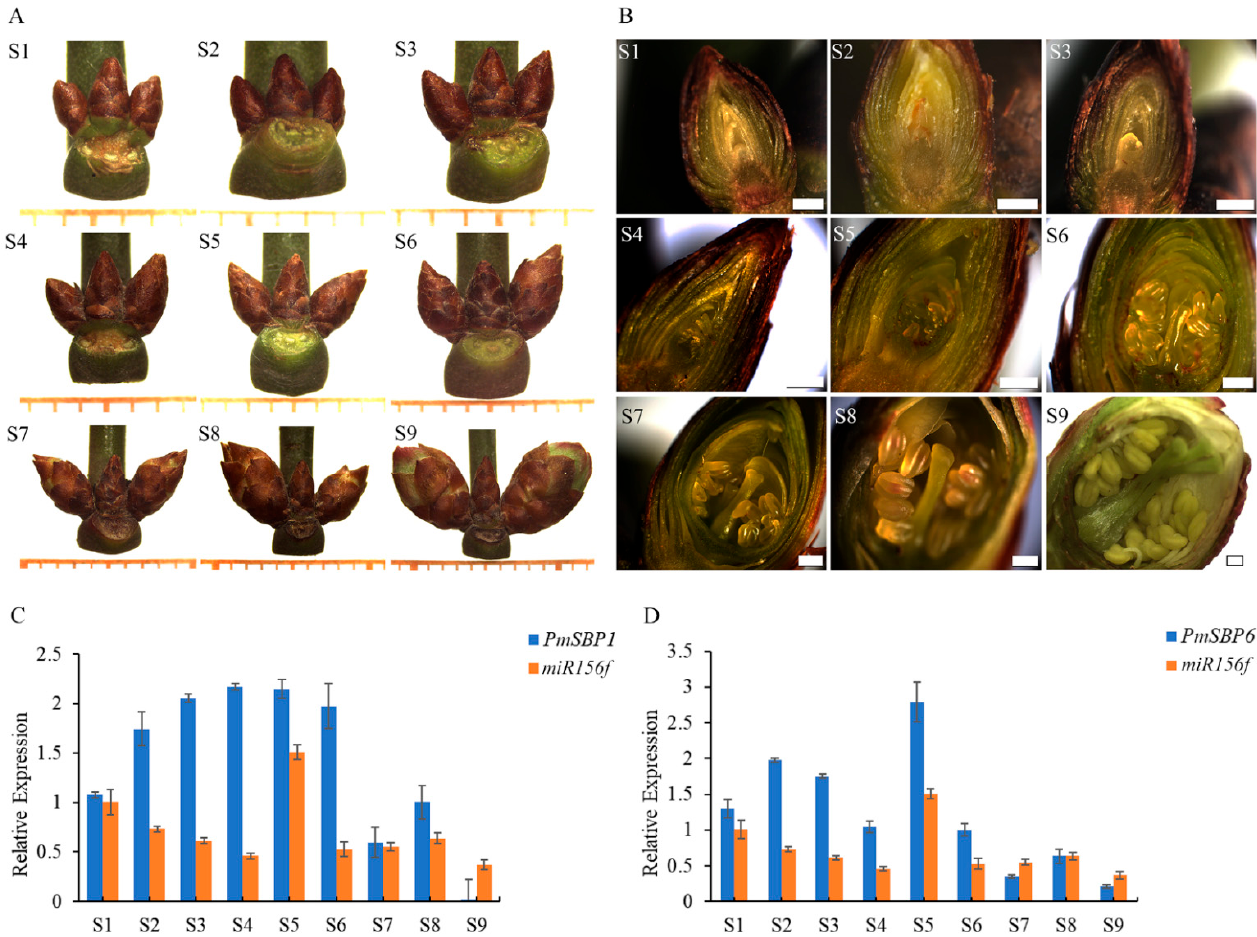
Figure 1. The flower development stages and the expression patterns of PmSBP1 / 6 and miR156f . ( A , B ) Flower buds at different development stages. S1: flower primordium forming stage, S2: sepal forming stage, S3: petal forming stage, S4: stamen forming stage, S5: pistil forming stage, S6: anther and ovule forming stage, S7: morphological differentiation finished stage, S8: alabastrum intumescence stage, S9: flower upcoming to bloom. S1–S7 belong to the flower bud morphological differentiation phase, and S6–S9 belong to the flower bud dormancy phase, the two phases have over- lapping parts. The minimum scale in ( A ) = 1 mm, and the scale bar in ( B ) = 400 µ m. ( C , D ) Expression patterns of PmSBP1, PmSBP6 and miR156f during the flower development